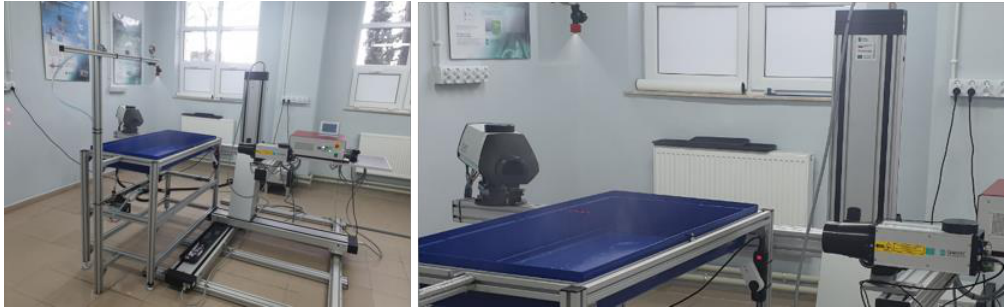
Figure 2. The analyzer 2D-Laser Doppler Anemometry / Phase Doppler Anemometry (2D-LDA / PDA) from Dantec Dynamics.